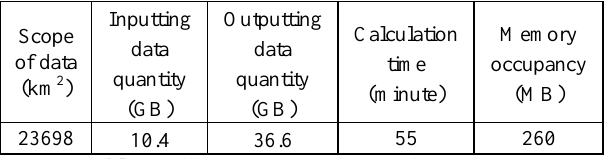
Table 4. Efficiency and capability of the